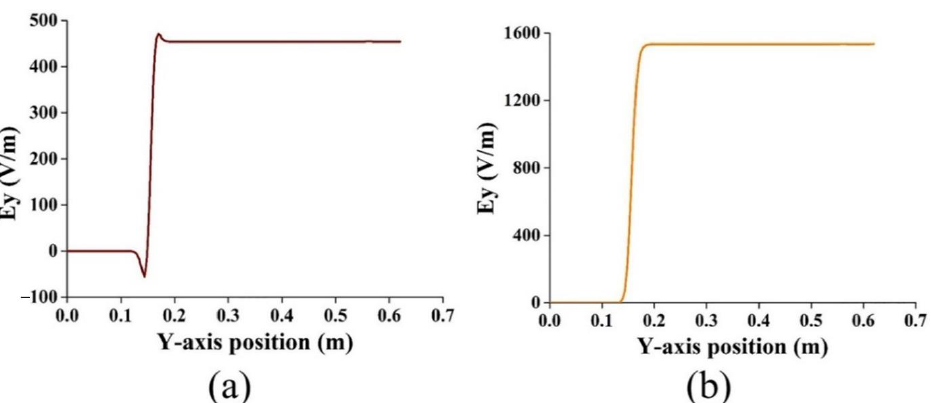
Figure 7. Distribution of Ey along Y direction from the gas inlet to the outlet with different applied voltages on the nozzle and ring electrode: ( a ) nozzle voltage of 6000 V and grounded ring; ( b ) nozzle voltage of 7000 V and ring voltage of 500 V.